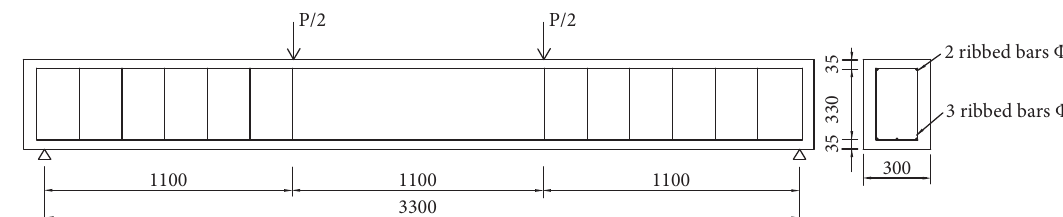
Figure 4: Layout of the reinforcement and loading arrangement (unit: mm).